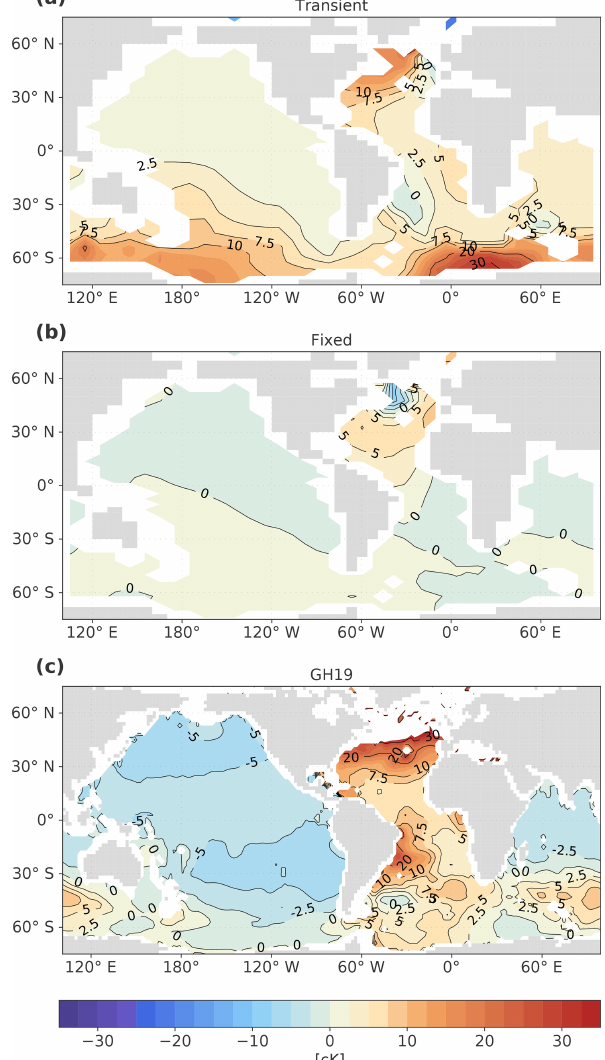
Figure 11. Comparison with Fig. 2 of Gebbie and Huybers (2019) for the two cases of transient and fixed circulation. Deep ocean tem- perature anomalies are determined between 1872 and 1876 ( Chal- lenger expedition) and between 1990 and 2002 (WOCE campaign) and averaged over the depth of 1800 to 2600m, for (a) simulation OcTRA (transient), (b) simulation OcFIX (fixed) and (c) the model output of Gebbie and Huybers (2019), Fig. 2, repeated here for easy